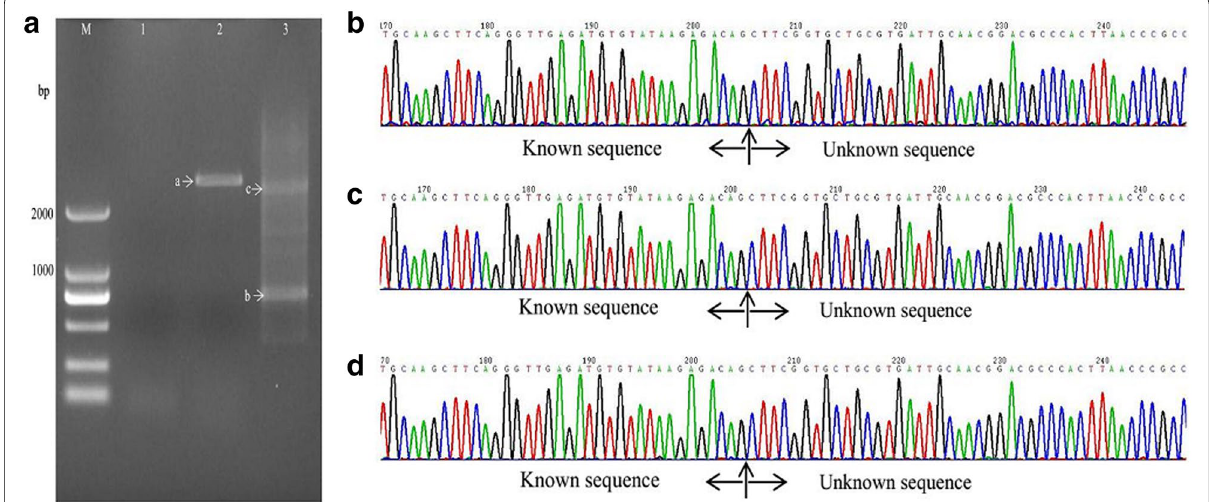
Fig. 4 Amplification and sequencing results of the sequence flanking the Tn5 insertion site of sample 3. a Amplification product showed on agarose gel. Lanes 1–3 show the results of steps 1–3, respectively. b Chromatograms of DNA in band a. c Chromatograms of DNA in band b. d